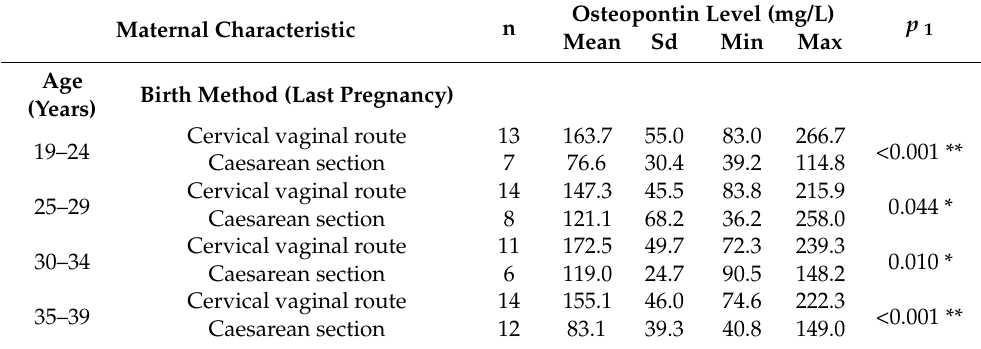
Table 4. Mean breast milk osteopontin levels according to age and birth